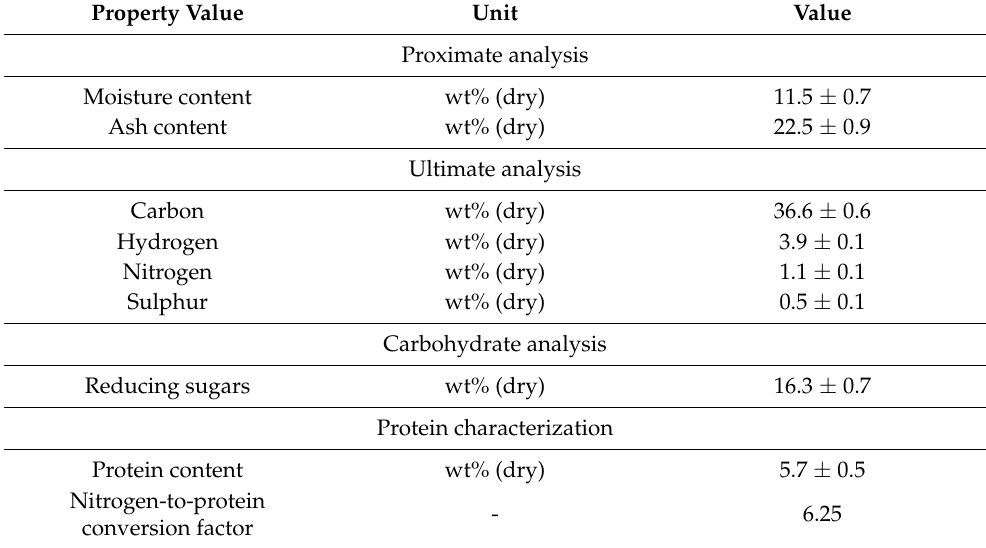
Table 1. Chemical characteristics of main Fucus spiralis